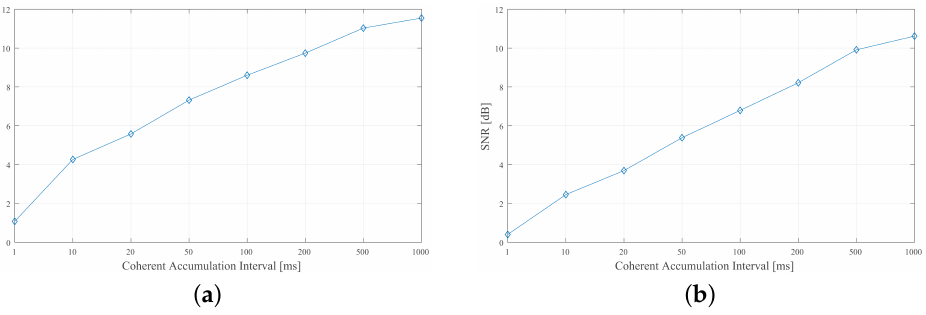
Figure 5. SNR results with respect to coherent accumulation interval. Calculated by the experimental data collected from Beidou-3 GEO satellites, on 15 April 2021 ( a ) C01 observation ( b ) C04